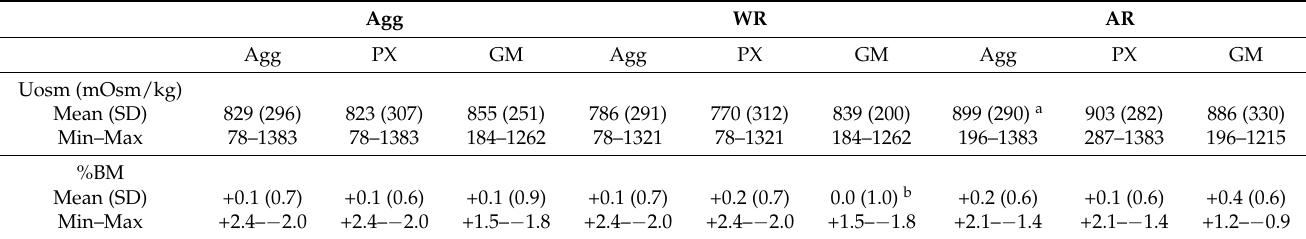
Table 2. Descriptive statistics for pre activity urine osmolality and percent change in body mass.